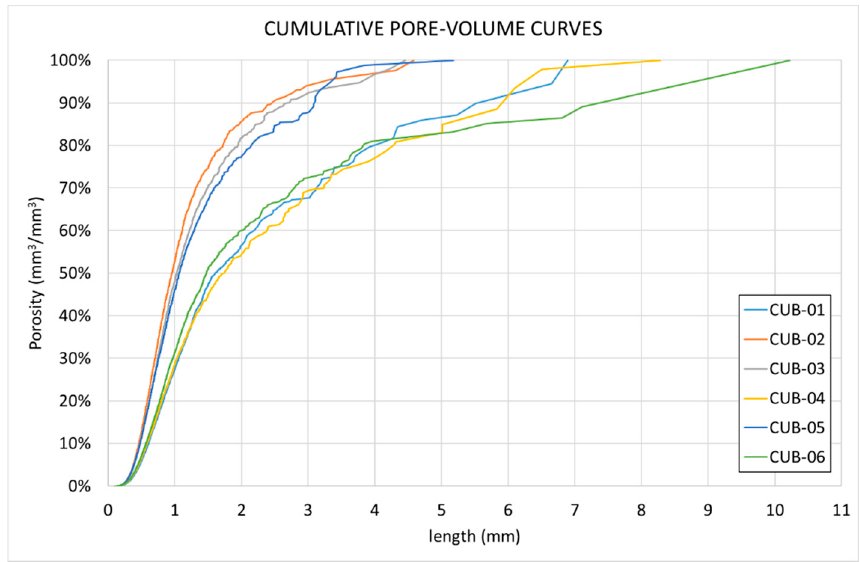
Figure 18. Cumulative pore-volume curves.